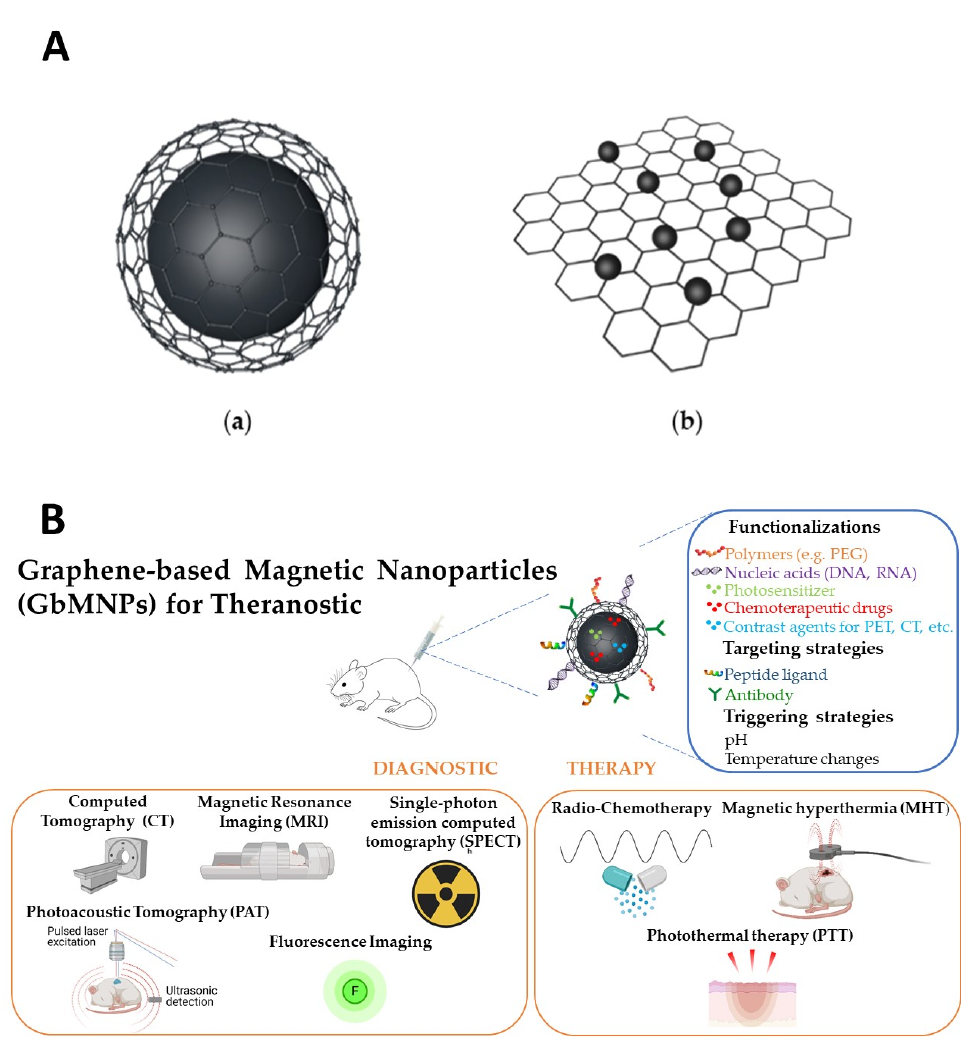
Figure 1. ( A ): Illustration of two basic configurations of GbMNPs. ( a ) Graphene-based materials encapsulated magnetic nanoparticles (GbEMNPs) and ( b ) graphene-based materials decorated with magnetic nanoparticles (GbDMNPs). ( B ): Schematic representation of graphene-based magnetic nanoparticles (GbMNPs), their usual functionalization, targeting and triggering strategies, as well as their most used combined diagnostic and therapeutic applications (theranostic) described in the literature. Created with BioRen-der.com.